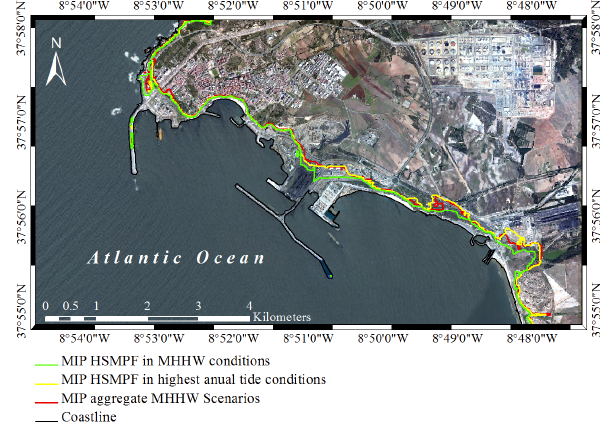
Figure 9. Comparison between the inundation extents (MIP) for HSMPF at MHHW, HSMPF at highest annual tide, and the aggre- gate